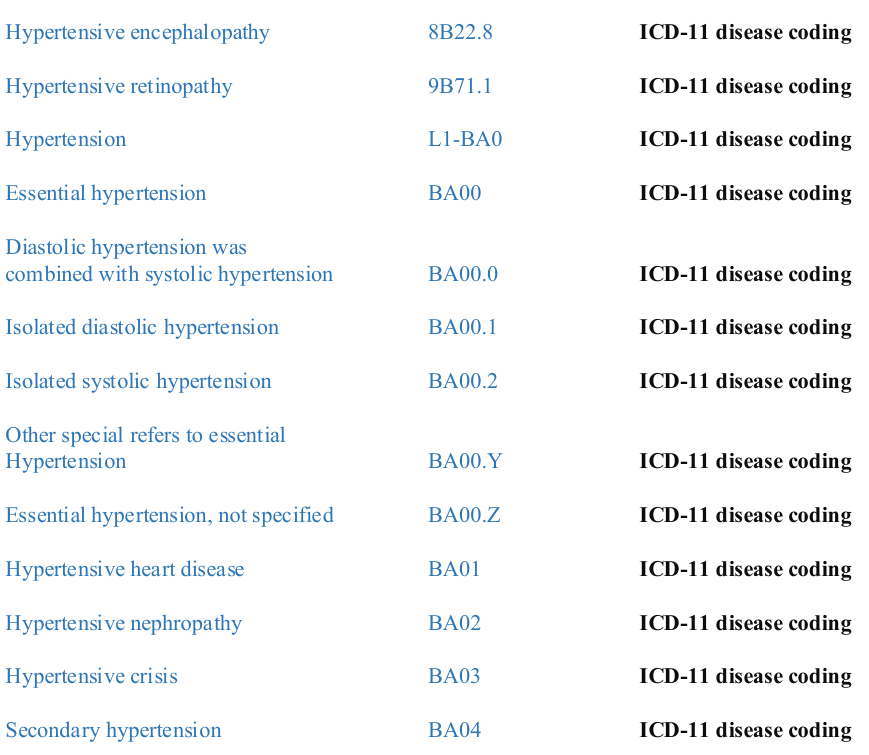
Figure 2. The ICD-11 part of the disease coding example.